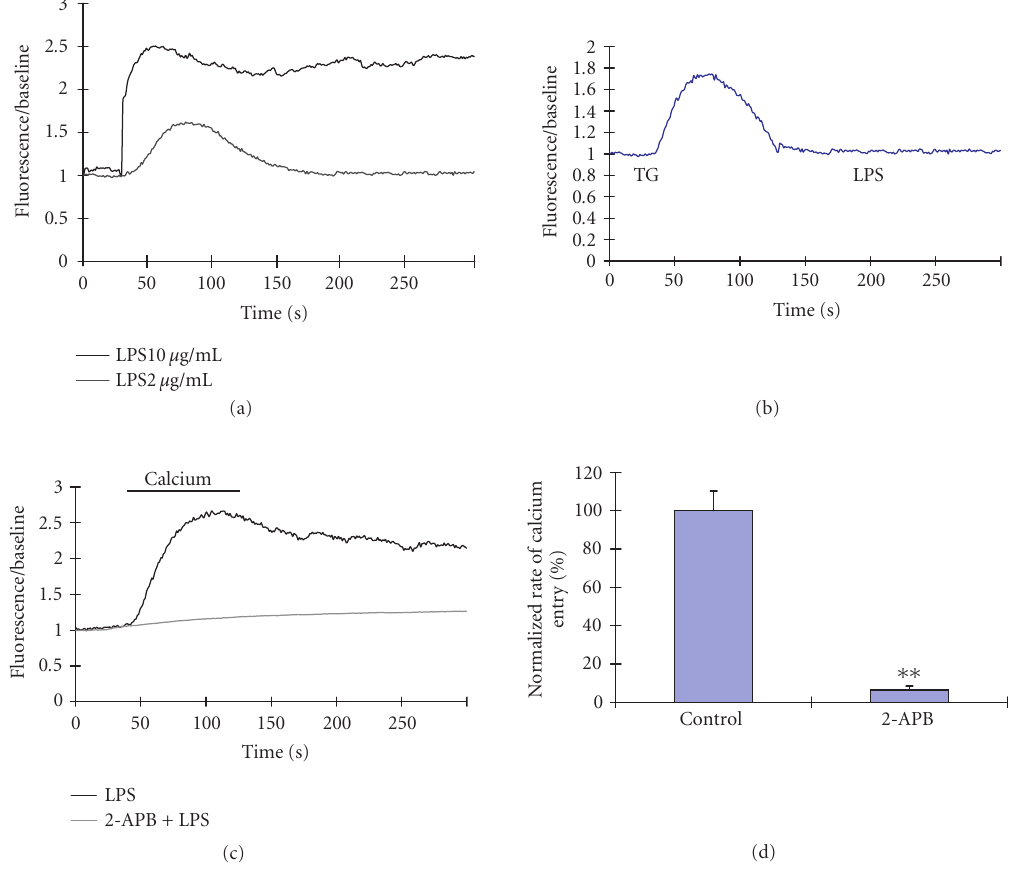
Figure 4: LPS stimulated Ca 2+ entry and [Ca 2+ ] i increase through CRAC channels. (a) LPS induced an elevation in calcium in RAW264.7 cells in the presence of external calcium. (b) After 3 minutes of 1 μ M thapsigargin treatment, the e ff ect of LPS (10 μ g/mL) on [Ca 2+ ] i increase was completely abolished. (c) 20 μ M 2-APB suppressed the Ca 2+ signal induced upon readmission of external Ca 2+ to cells pretreated for 8 minutes with LPS (2 μ g/mL) in Ca 2+ -free solution. 2-APB was added just 2 minutes before the readmission of the Ca 2+ . (d) The summarized aggregate data compares the e ff ects of the control and 2-APB on the initial rate of Ca 2+ entry following readmission of the Ca 2+ to cells with stores depleted by LPS. The rate of Ca 2+ influx was obtained by measuring the initial slope of the Ca 2+ rise following readmission of Ca 2+ to cells with depleted stores. 2-APB was added just 2 minutes before the readmission of the Ca 2+ . Three independent experiments have been performed. Figures 4(a), 4(b), 4(c) are representative of at least three experiments performed on di ff erent experimental days. (cid:0)(cid:0) P < . 01 versus control